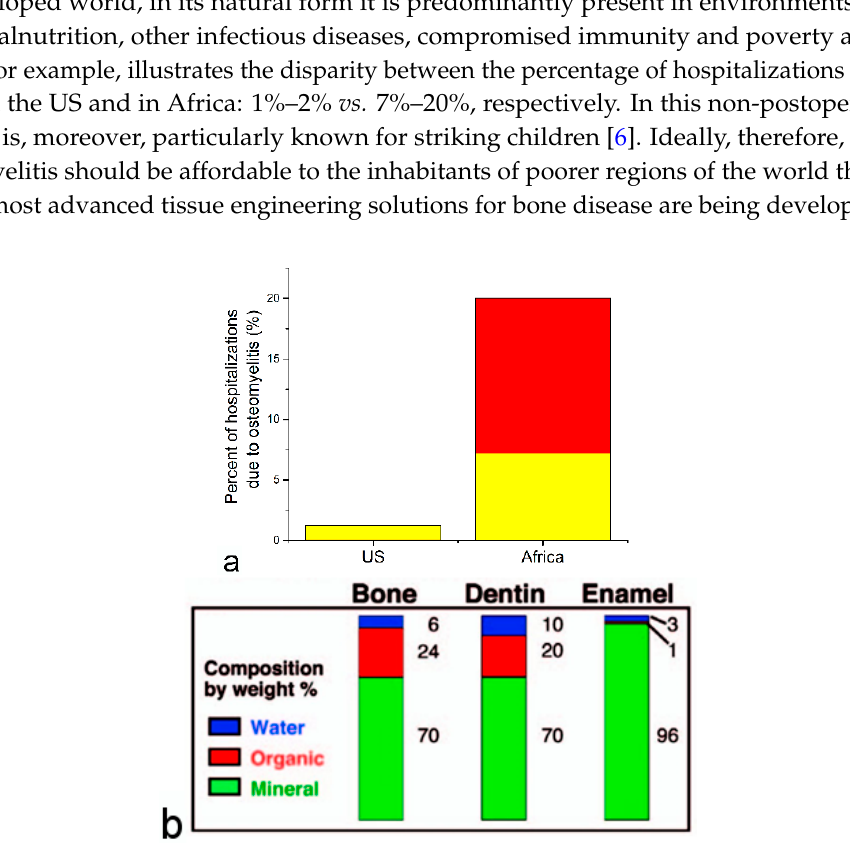
Figure 1. ( a ) Percentage of hospitalizations due to osteomyelitis, equaling 1.23% in the United States and ranging from 7% to 20% in Africa. The area below and above 7% differs in color—yellow and red, respectively. Data retrieved from Refs. [7–9]; ( b ) Percentage of mineral, organic, and aqueous components of three major hard tissues in the human body, demonstrating calcium phosphate (CAP) as the most abundant component of each of the three of them: bone, dentin and enamel. Adapted from [10] with permission from ©2008 Mineralogical Society of